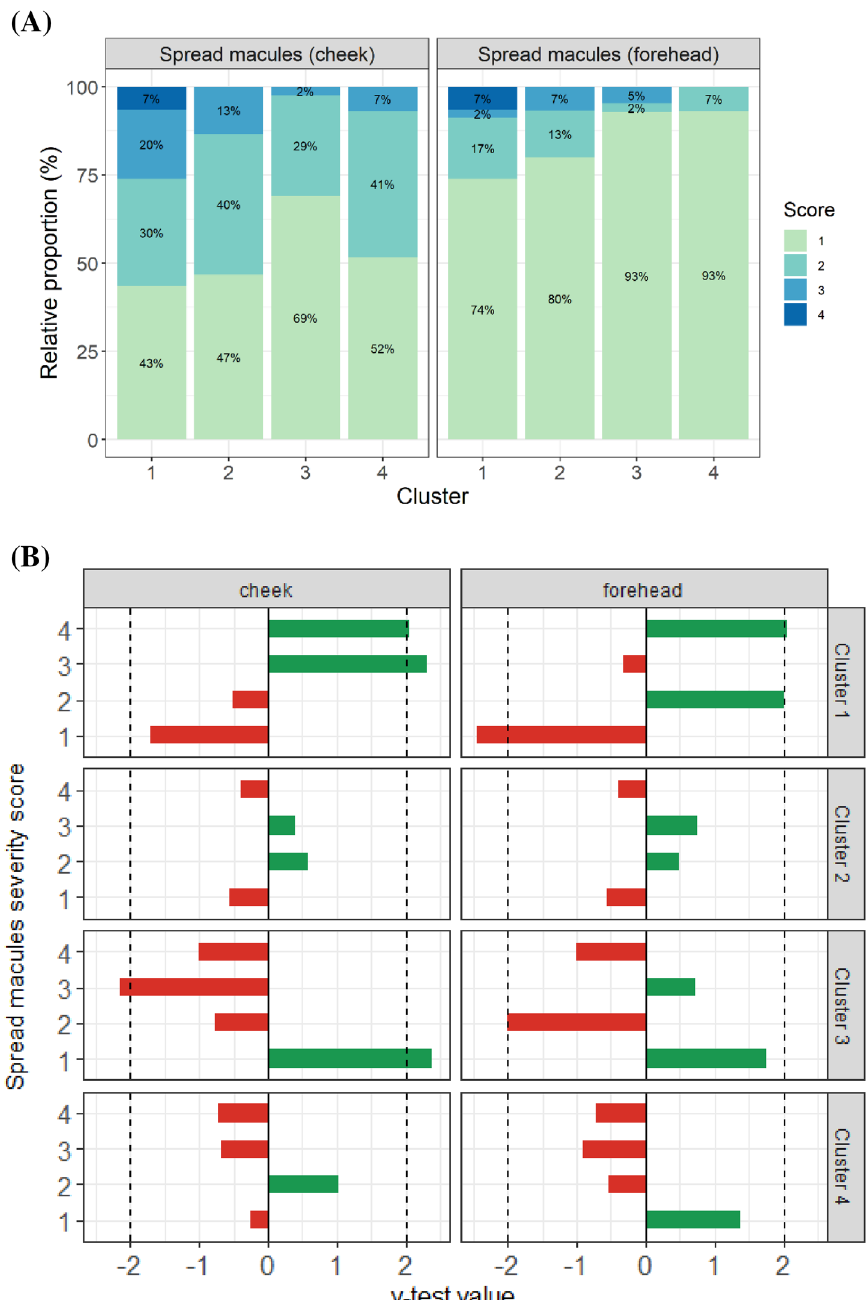
Figure 7. ( A ) Relative proportion of Spread Macules severity score in the consensus clusters. A score of 1 correspond to “no spread macules”, a score of 2 to “weak spread macules”, a score of 3 to “moderate spread macules” and a score of 4 to “severe spread macules”. ( B ) Characterization of consensus clusters by Spread Macules severity score using v-test statistic. In row we represent the consensus clusters and in column the location of the spread macule score on the face (cheek or forehead). A positive v-test value (in green) indicates that the severity score is in higher proportion in the cluster compare to the global population. A negative v-test value (in red) indicates that the severity score is in higher proportion in the cluster compare to the global population. The v-test value is considered significant if it reaches a threshold of 2 (black dotted vertical line on the plot). Figures were created using the R software: R Core Team (2017), R Foundation for Statistical Computing, Vienna, Austria. URL https:// www.R- proje ct.